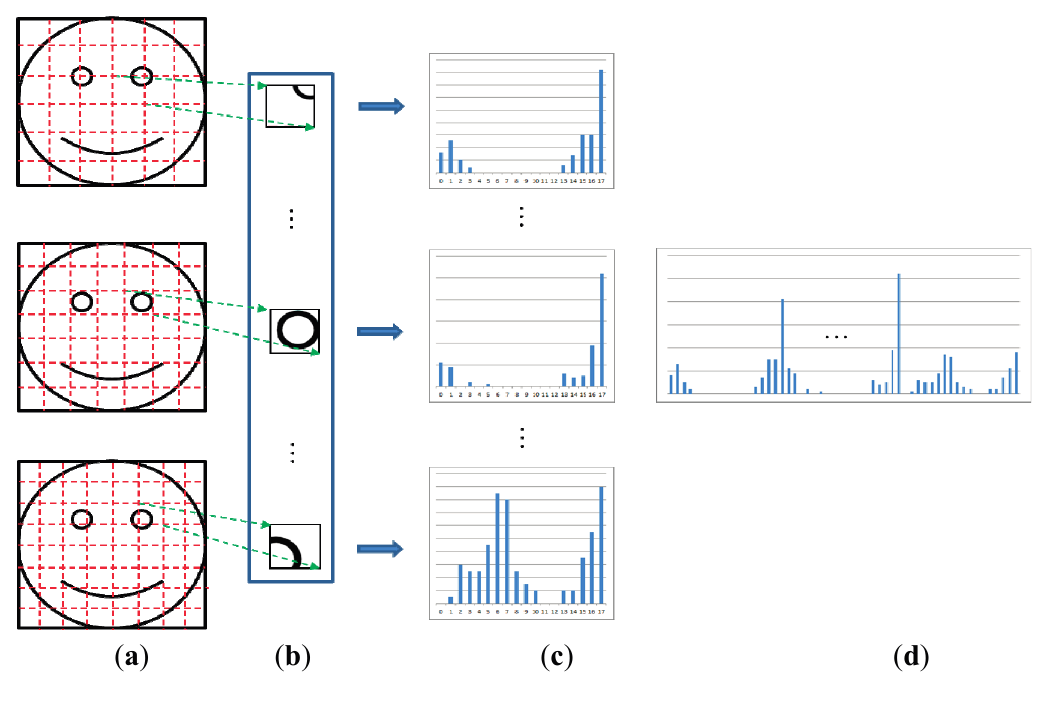
Figure 13. Extracting the histogram features using MLBP at three levels: ( a ) Face image that is divided into sub-blocks; ( b ) Sub-block regions; ( c ) Histograms for (b) created using LBP; ( d ) Final feature histogram obtained by concatenating the histograms from